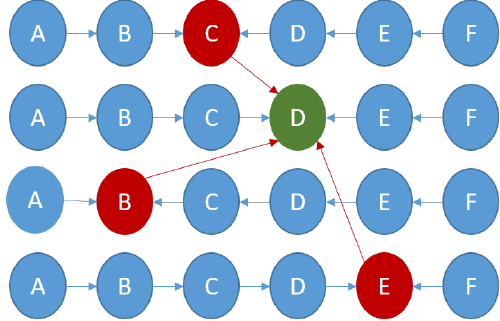
Figure 15. MQ-Chain-MH